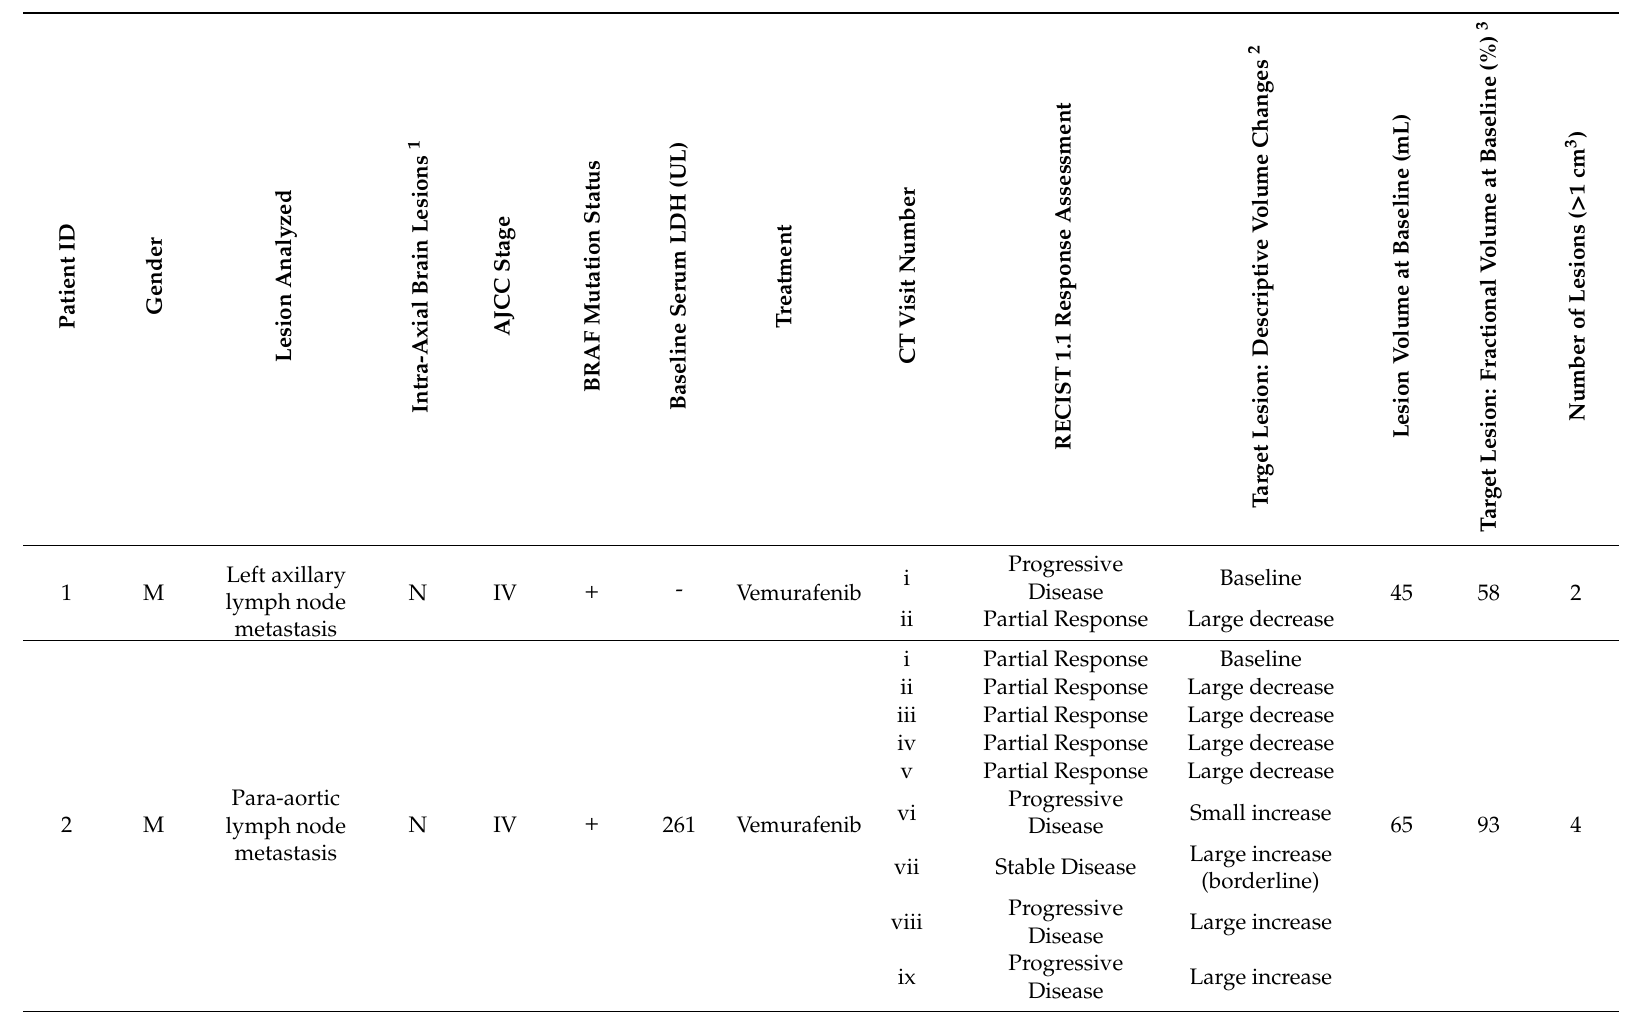
Table 1. Clinical characteristics of study